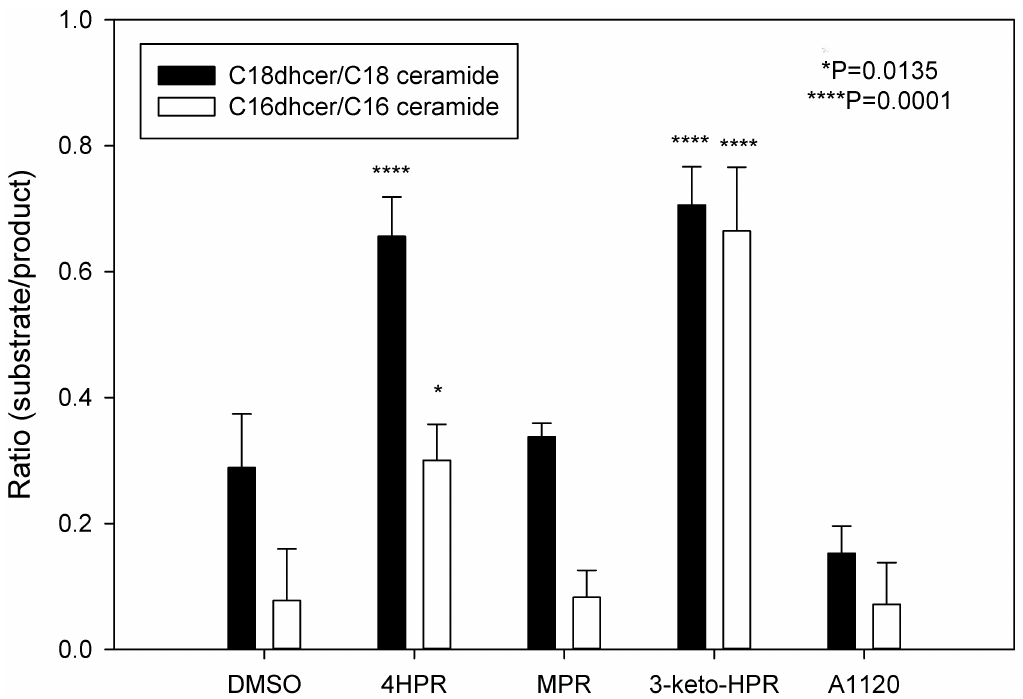
Fig 3. Effect of fenretinide and its metabolites on DES1 activity. ARPE-19 cells were treated with fenretinide,its metabolites, A1120 (all at 10 μ M) or vehiclefor 24 h, and endogenousC16 and C18 ceramides measuredby LC/MS. Suppressionof DES1 activity by fenretinideand its metabolites is confirmedby the highersubstrate/product (dihydroceramide/ceramide) ratio relative to the DMSO control. The presenceof fenretinide or 3-keto-HPR led to a greater accumulationof C16 and C18 dihydroceramide than did MPR or A1120. Lipids were extracted from one 100 mm Petri dish for each biological replicate and subjectedto mass spectrometry analysis. Data plotted as means ± standarddeviation;n =